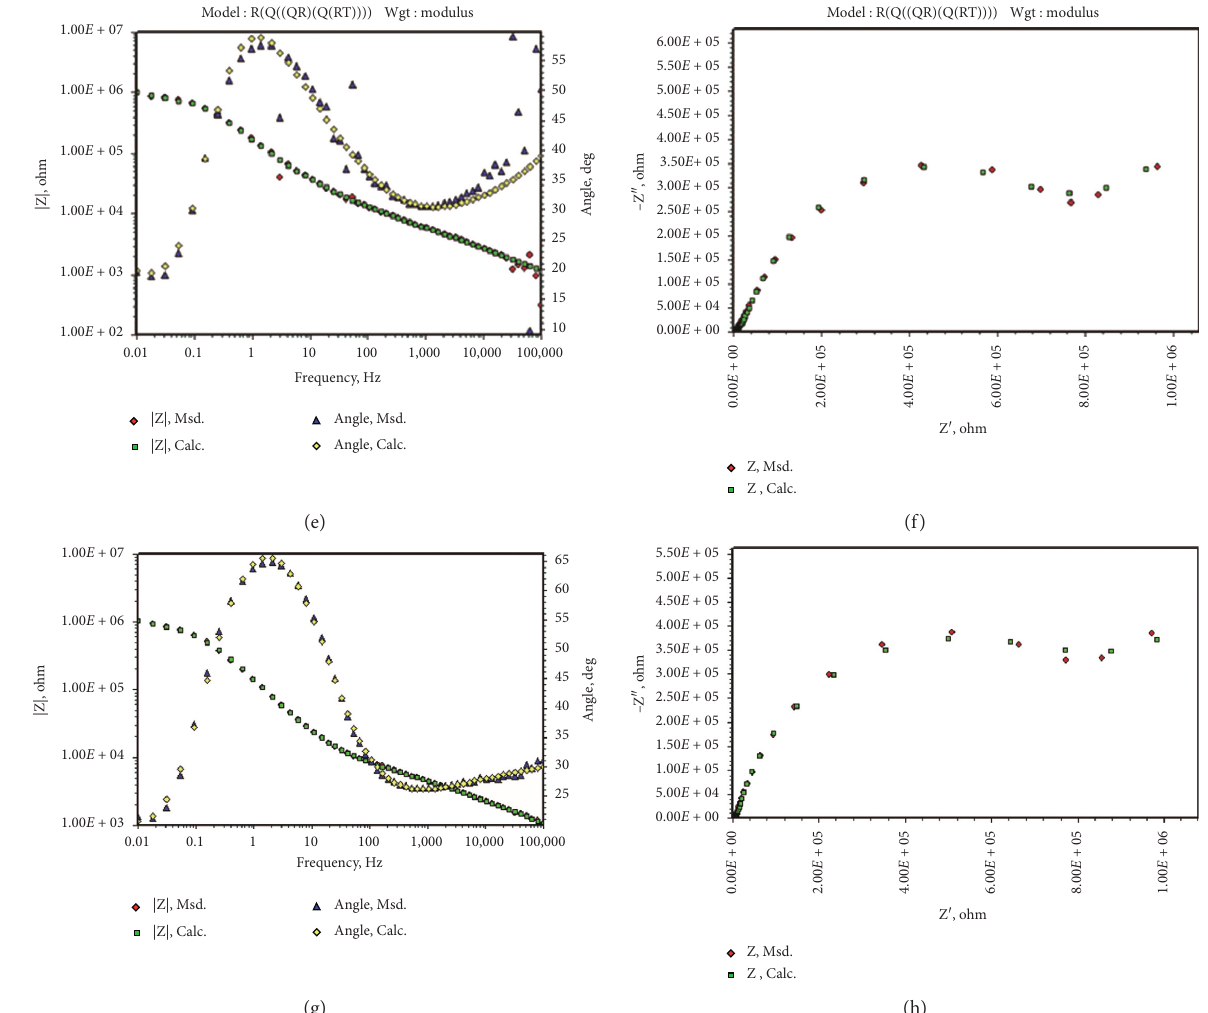
Figure 12: Bode and Nyquist curves of anodic oxidation coating after being immersed in 3.5 wt.% NaCl solution for (a, b) 1 day, (c, d) 12 days, (e, f) 32 days, and (g, h) 63